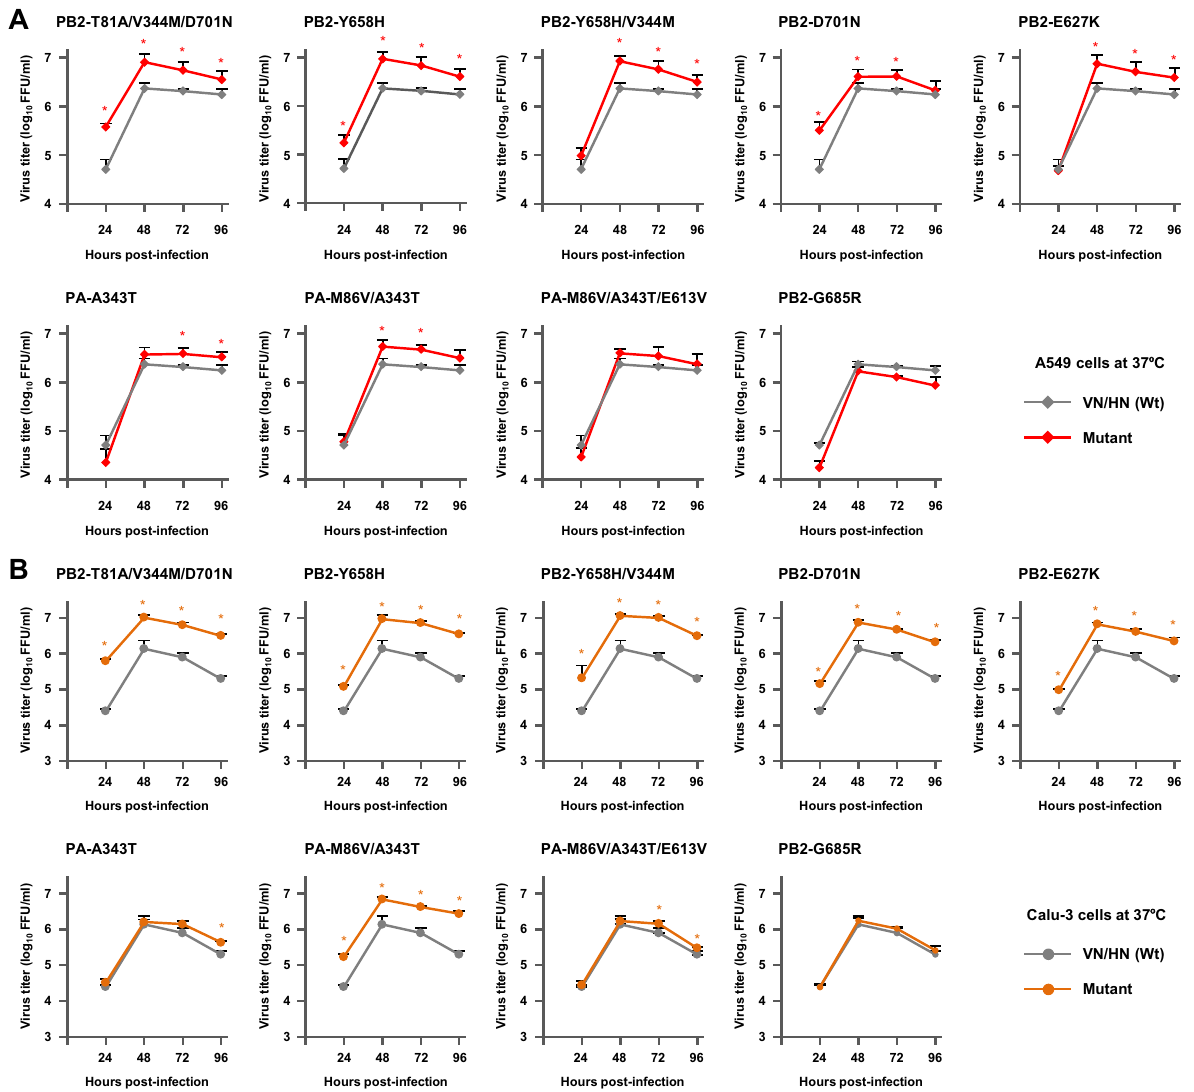
Figure 2. Effect of H5N1 polymerase mutations on viral growth in human airway epithelial cells at 37 °C. ( A ) A549 cells and ( B ) Calu-3 cells were infected with the indicated VN/HN viruses at an MOI of 0.03 and incubated at 37 °C. The culture supernatants were harvested at the indicated times and assayed by focus-forming assays to determine the progeny virus titers. Each data point is the mean ± SD of the log 10 FFU/ml from three separate experiments. An asterisk indicates a P value < 0.01 (ANOVA with Tukey’s multiple comparison